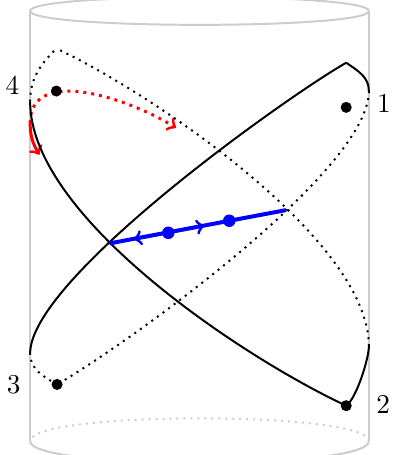
Figure 1. A four-point function near the Regge limit. Bulk excitations localize along two null sheets, which intersect in a transverse hyperbolic space H arrows show the boundary and bulk actions of SO( d − 1 , 1) isometries, which we exploit to focus in impact